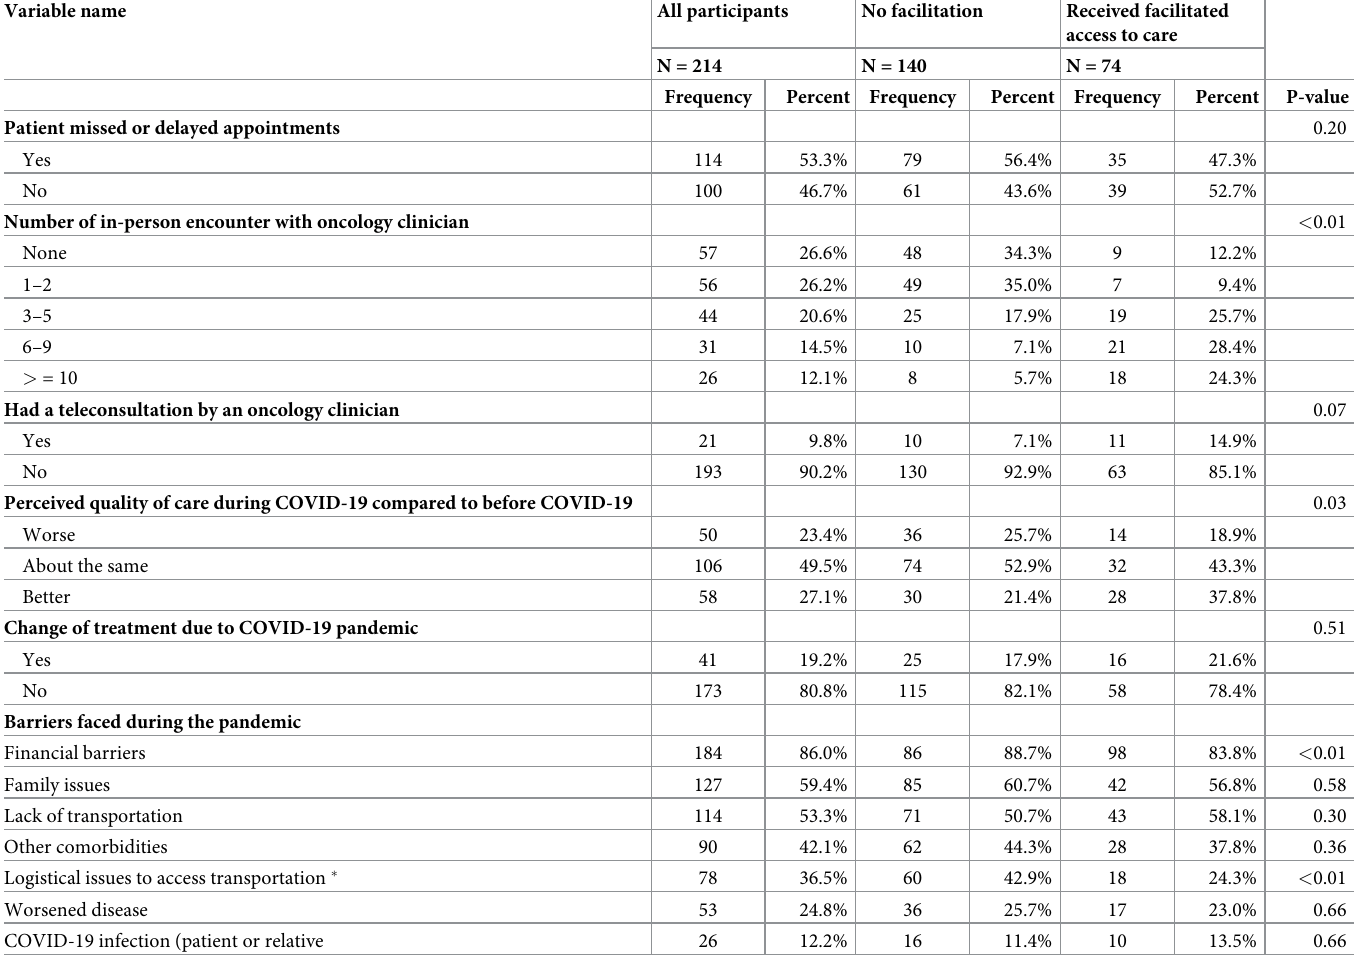
Table 2. Cancer care during COVID-19 pandemic, stratified by receipt of facilitated access to care (N = 214). Variable